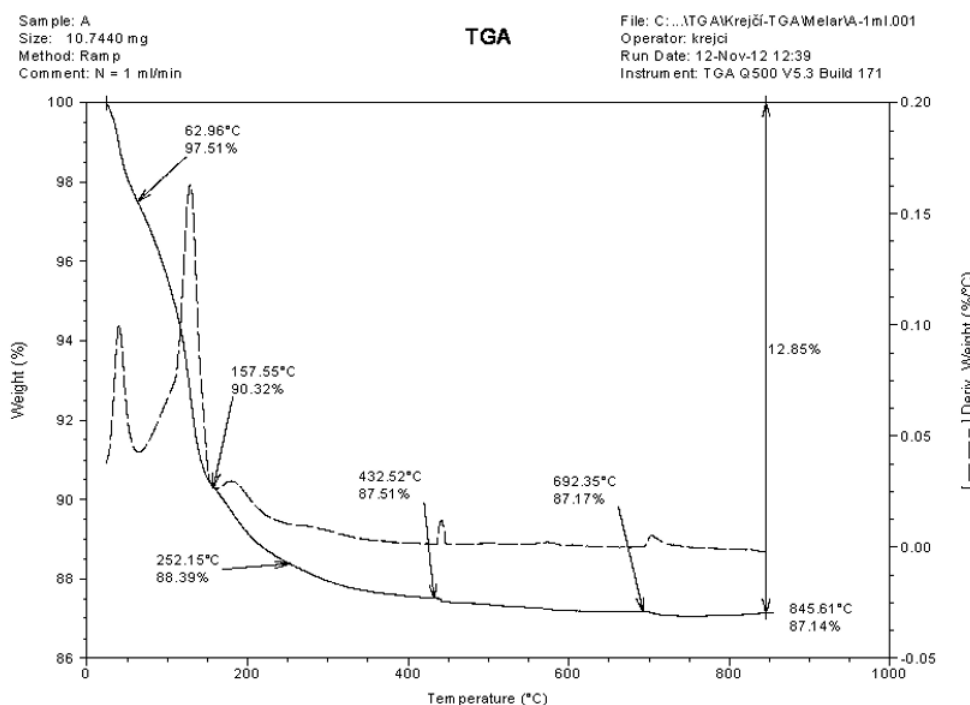
Figure 6. TG/DTG curve of a sample that was hydrothermally treated for 25 days.